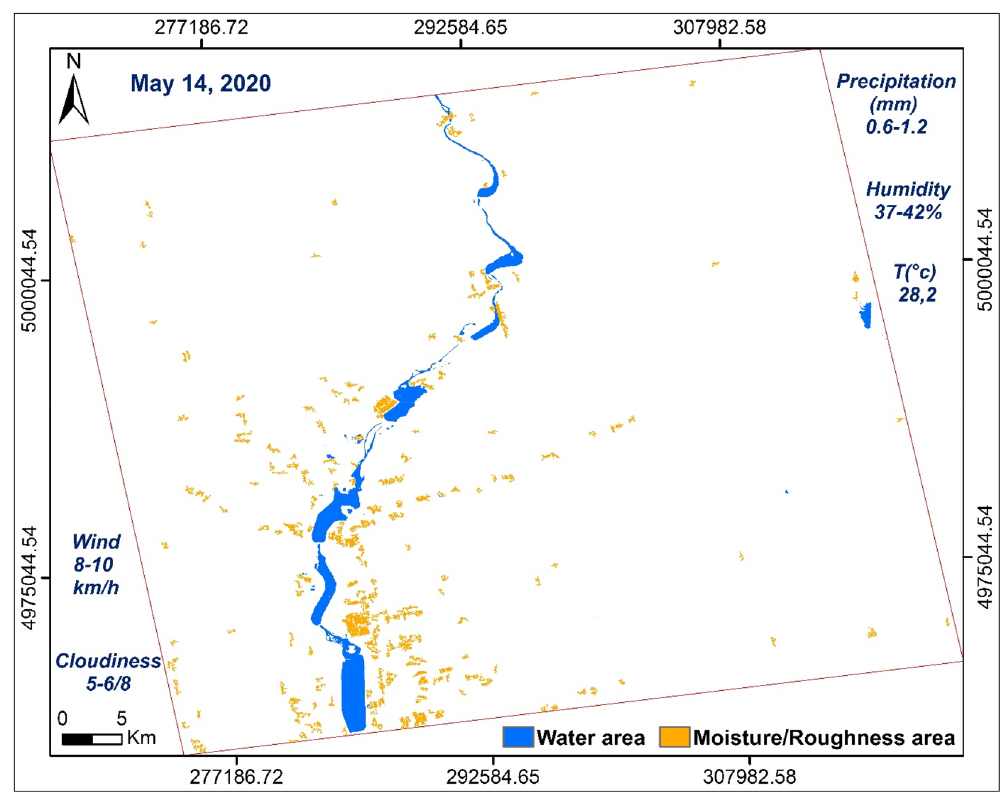
Figure 6. Map produced using ArcGisPro 2.8.1, showing areas of water and moisture/roughness,